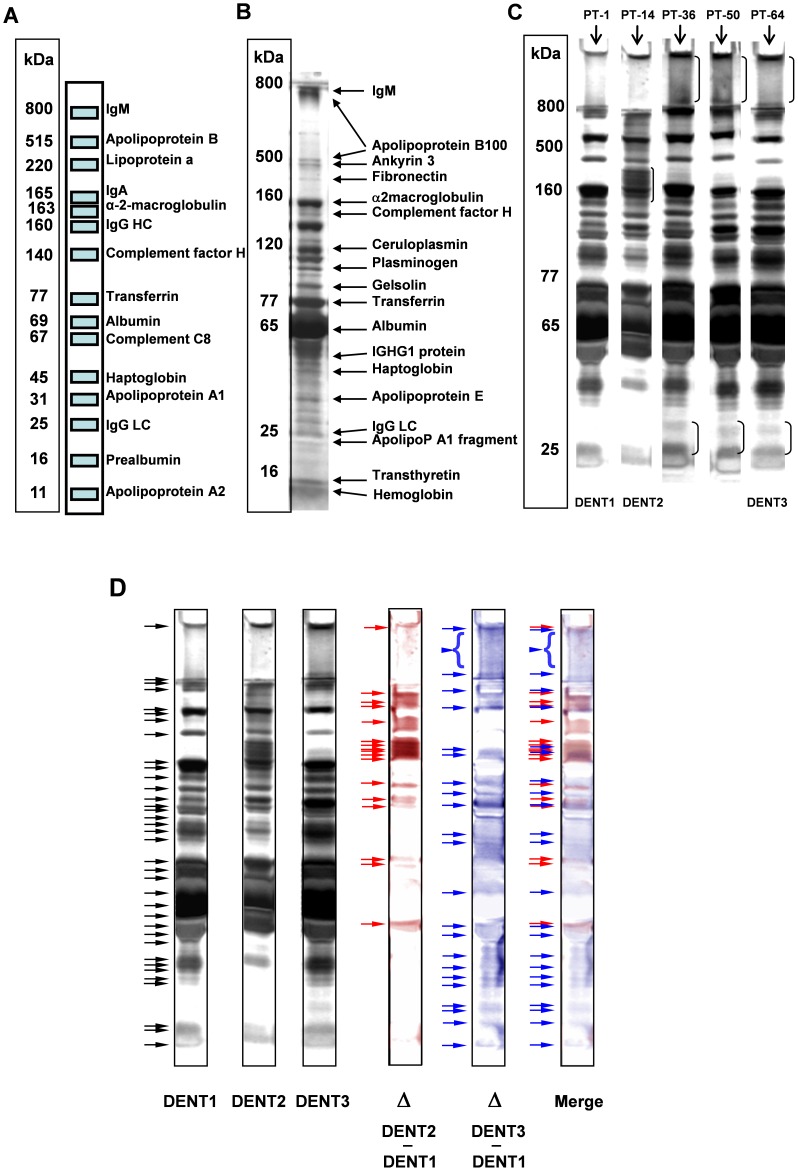
Effects of differential denaturation on serum electrophoretic separation.A: The serum protein pattern as described in literature and as obtained with DENT1 protocol in a 16×18 cm gradient SDS-PAGE (2.4–15%), shown in panel B, by MALDI-TOF/MS analysis of cut and digested protein bands. C: Representative electrophoretic separation of human pooled sera derived from the most discriminating sample pre-treatments (described in Table S1, thereafter defined as DENT2 and DENT3 treatments) compared to the reference treatments (DENT1). Samples were run on a manually poured gradient slab gel (2,4–15%): 120 µg of proteins loaded per lane. Asterisks indicate some of the protein bands undetectable or less detectable in DENT1 but evident in the pre-treatments specifically developed in the present study. D: Graphical representation of the improvement of protein band resolution and discrimination after DENT2 or DENT3 pre-treatments compared to the DENT1. The protein pattern identified as Merge indicates the gain of protein band detection and discrimination.